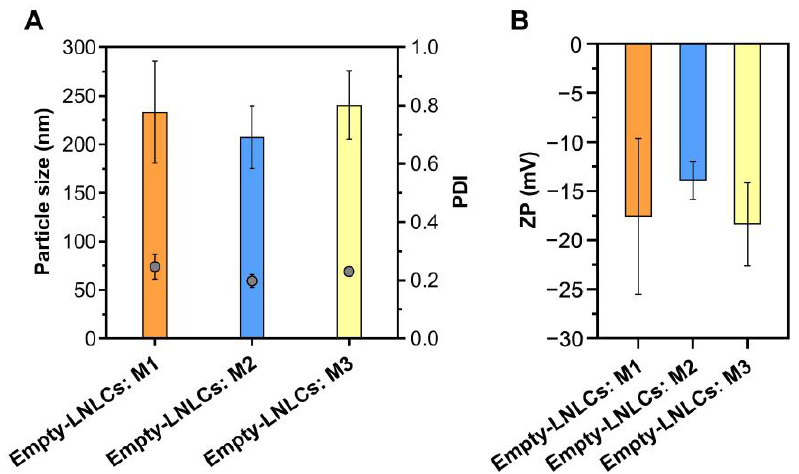
Figure 2. Physicochemical properties of empty LNLCs prepared by hydrotrope method (M1), lipid film hydration method (M2) and emulsification method (M3): ( A ) size and polydispersity index (PDI), and ( B ) surface charge (zeta potential, ZP). The data are expressed as mean ± standard deviation of three independent measurements.